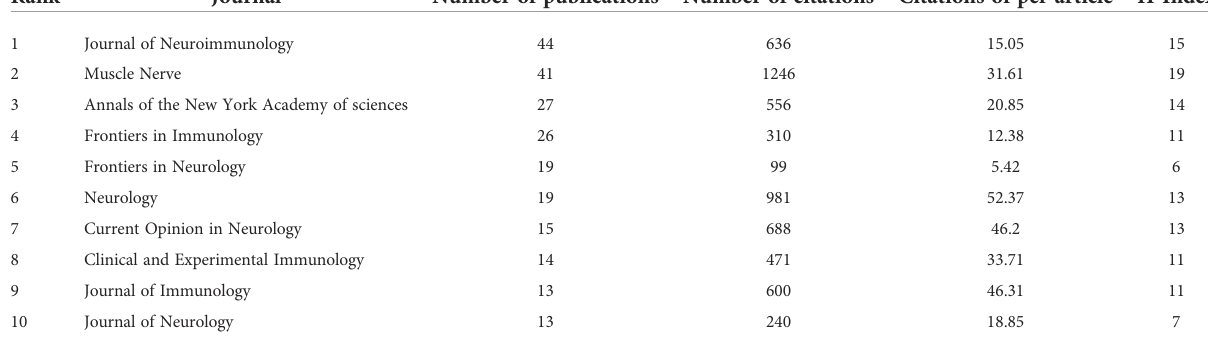
TABLE 4 Top 10 journals with most publications in the fi eld of targeted immunotherapy for MG.